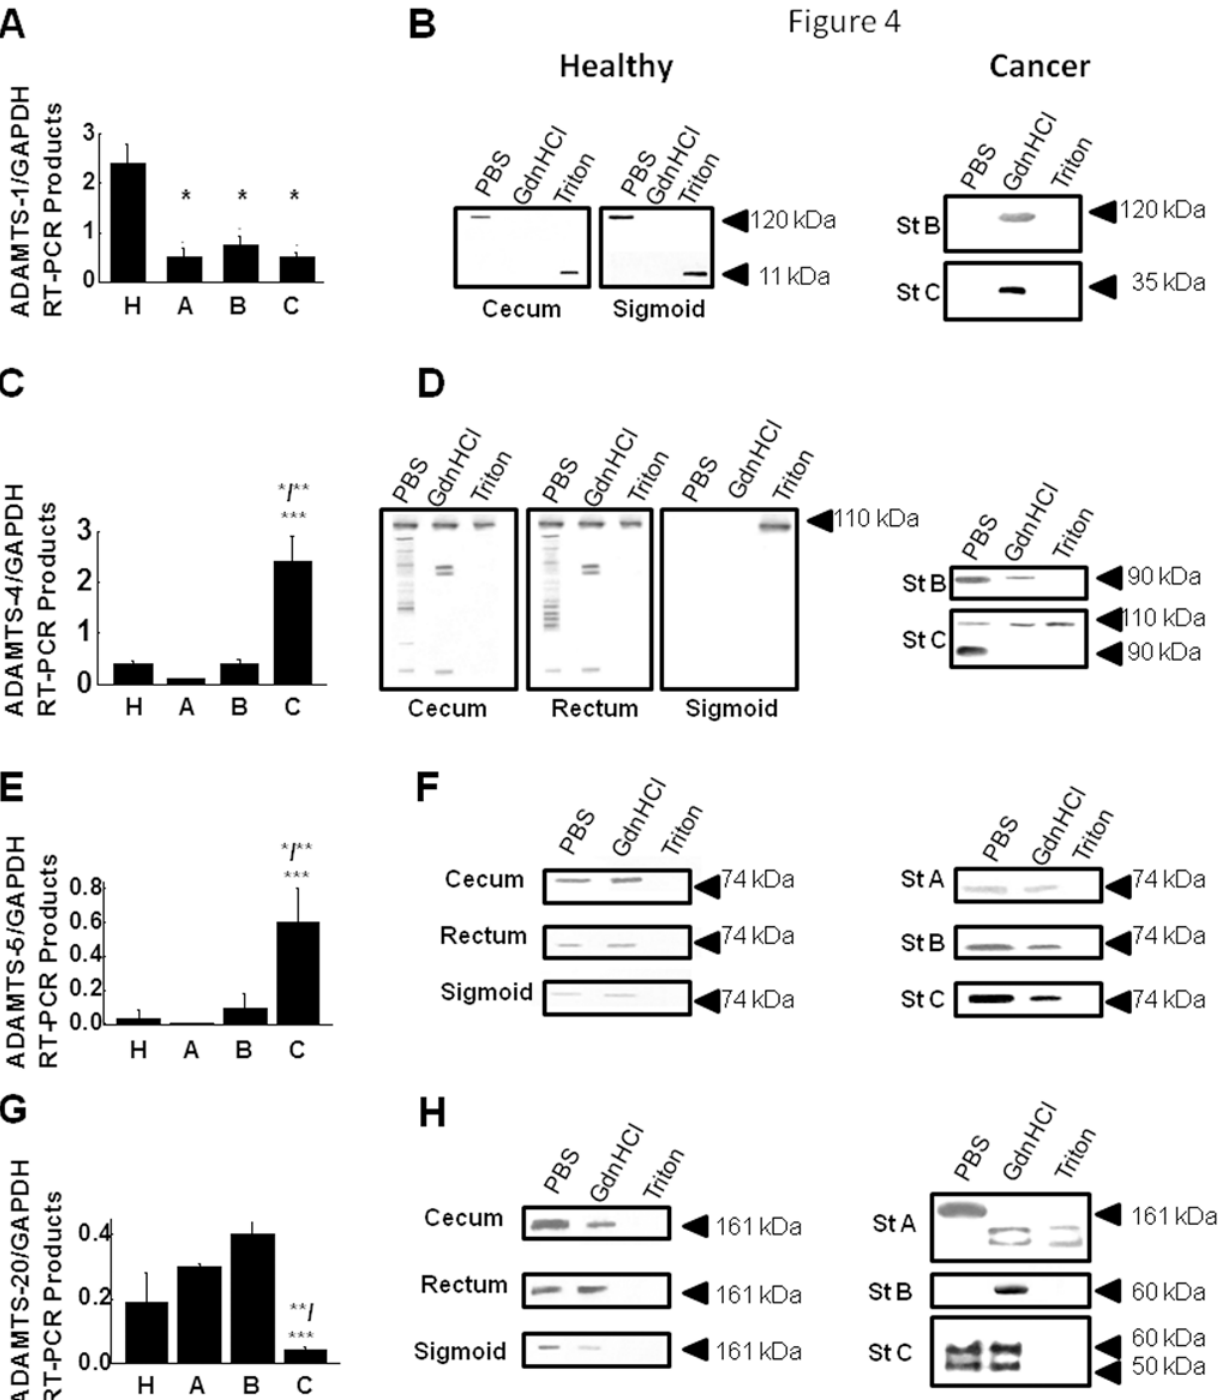
Fig 4. Expression of ADAMTSs in healthy and cancerous colon tissues. Semi-quantitative RT-PCR analysis of (A) ADAMTS-1, (C) ADAMTS-4, (E) ADAMTS-5 and (G) ADAMTS-20. Values are the mean GAPDH-normalized ± S.D. Protein distribution of (B) ADAMTS-1, (D) ADAMTS-4, (F) ADAMTS-5 and (H) ADAMTS-20. * P (cid:1) 0.05; statistically significant differences compared to healthy tissues. ** P (cid:1) 0.05; statistically significant differences compared to stage A. *** P (cid:1) 0.05; statistically significant differences compared to stage B. Healthy Cecum, Rectum and Sigmoid colon tissues are shown; A-C : Duke ’ s CRC stages. Arrows indicate the migration of molecular mass markers. PBS, GdnHCl and Triton are the sequential extracting solutions used (see text).